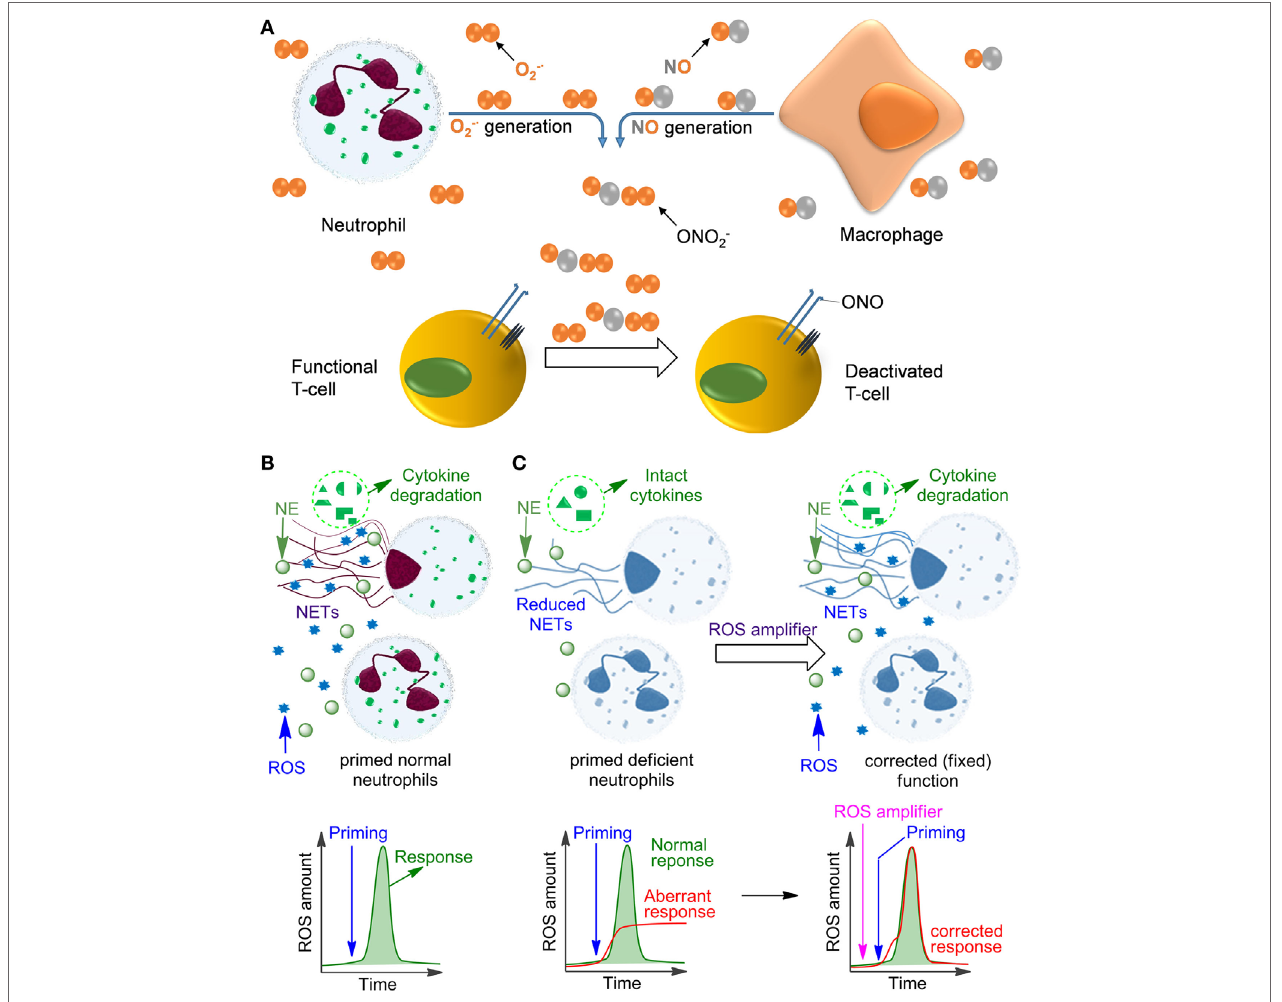
FigURe 1 | Influence of reactive oxygen species (ROS) on immune cell function. (A) The mechanism of deactivation of T-cells by ROS and reactive nitrogen species produced by neutrophils and monocytes/macrophages. This process is facilitated by the proximity of macrophages and T-cells at the sites of infection due to binding of the T-cells to antigens presented on the macrophage surface. (B) Oxidative burst in normal primed neutrophils leading to ROS production and neutrophil extracellular trap (NET) formation. (C) Aberrant response of NADPH oxidase 2-deficient neutrophils (e.g., in chronic granulomatous disease) leading to low ROS and insufficient NET formation. This deficiency can be fixed by applying ROS